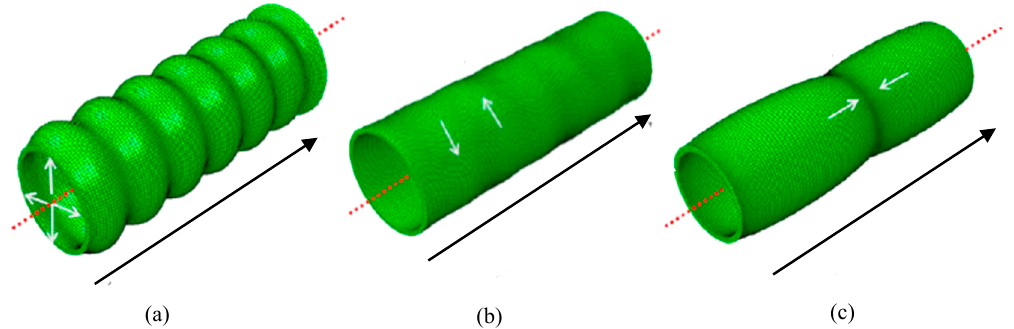
Figure 3. Displacement patterns of the axisymmetric modes ( a ) L(0,1) ( b ) T(0,1), and ( c ) L(0,2). The black arrow represents the direction of propagation, and the red dashed line represents the central axis.